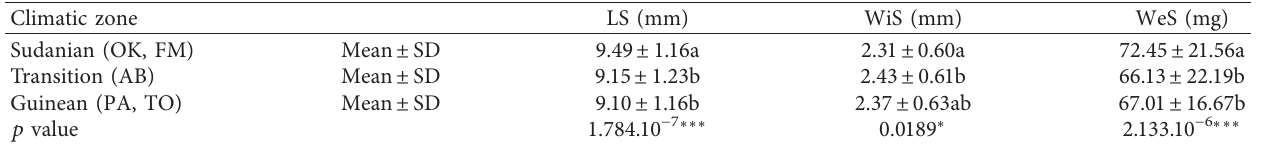
Figure 10: Distribution of trees’ seed characteristics at the five sites. Table 13: Mean values of the seeds’ parameters according to the climatic